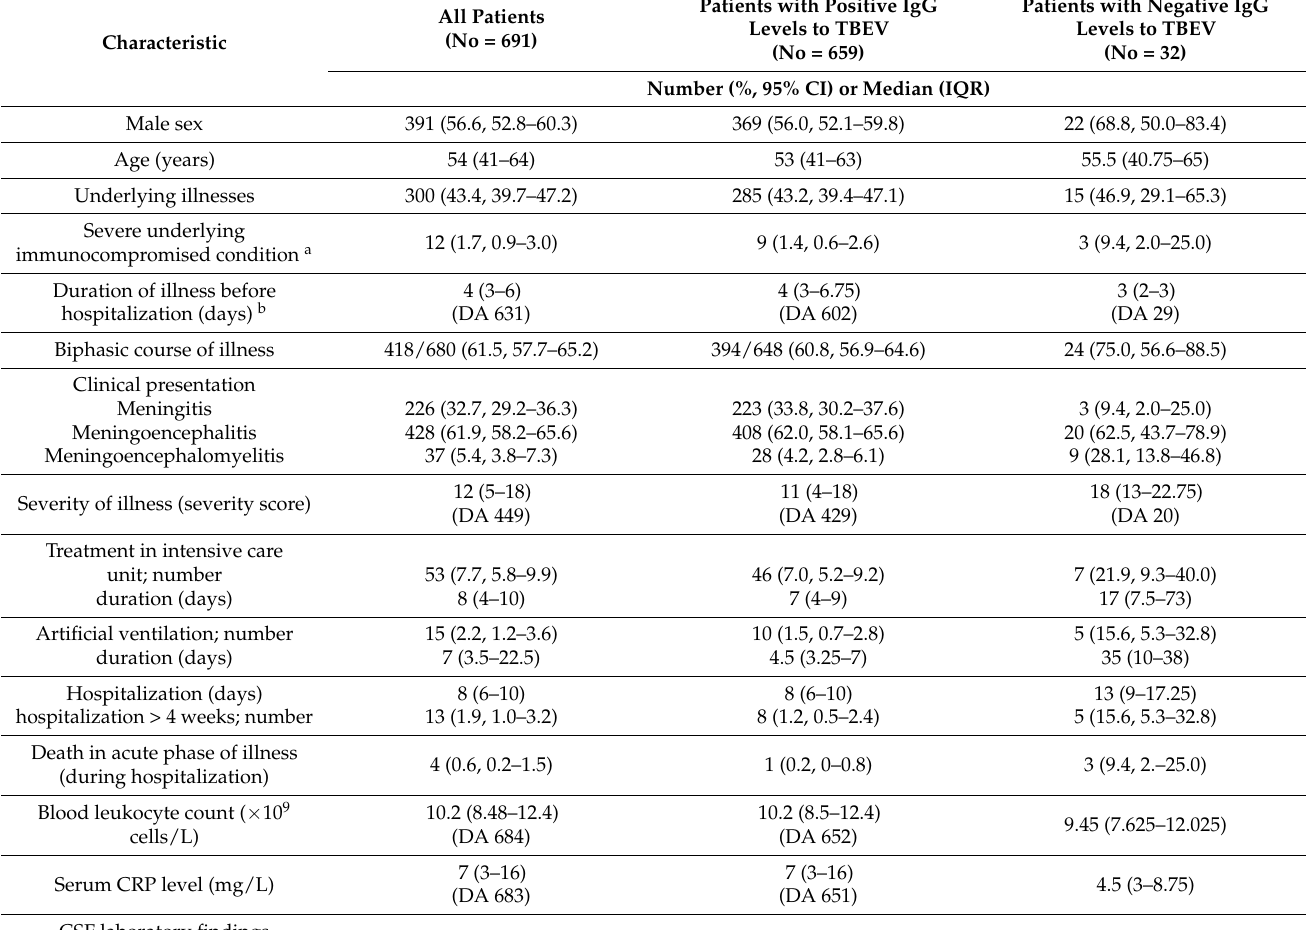
Table 1. Basic demographic, clinical, and laboratory data on 691 adults with tick-borne encephalitis.